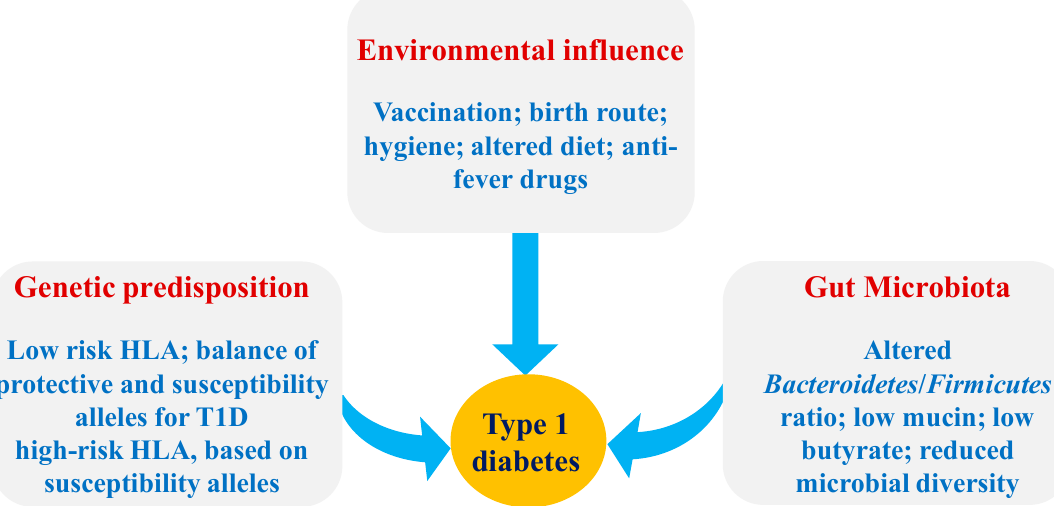
Figure 1. Factors influencing the susceptibility of T1D. Abbreviations: HLA: Human leukocyte antigen; T1D: Type 1-Diabetes.